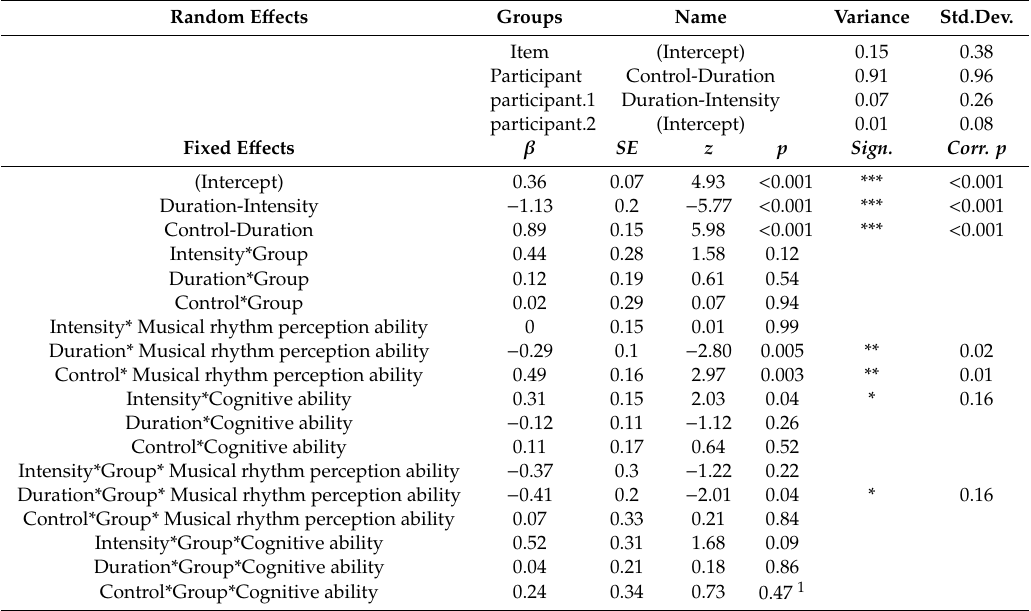
Table A8. Output of the fourth model that extends model 3 by cognitive ability as control variable, which did not improve the model